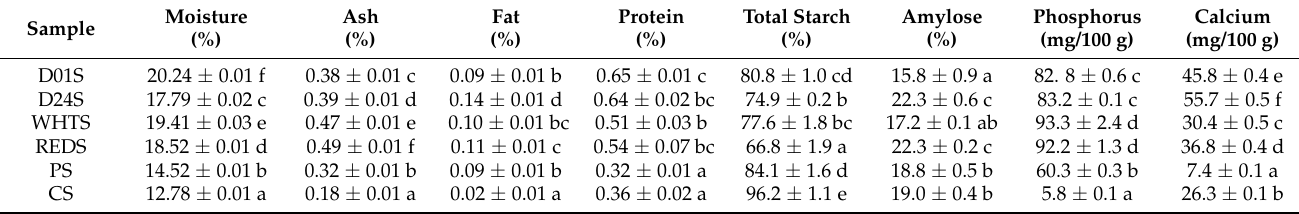
Table 2. Proximate composition; total starch; and amylose, phosphorus, and calcium content of anchote cultivars, potato, and cassava starches. All results, except moisture, are referred to as the weight of dry matter.